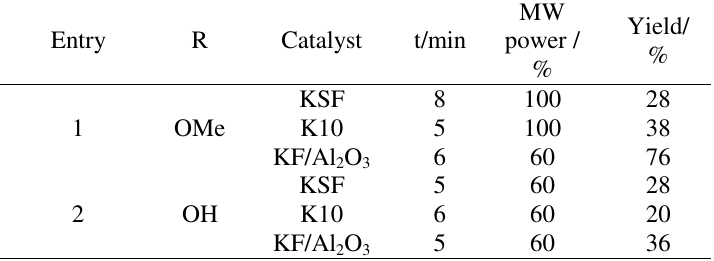
Table 1. Aldoximes Dehydration Under Microwave